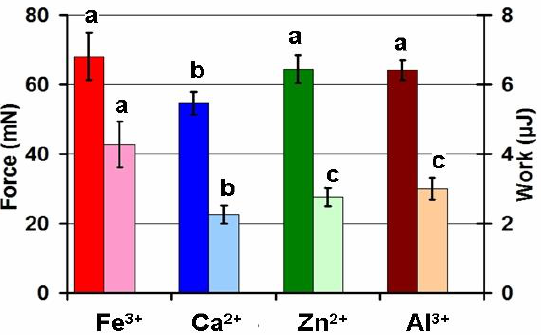
Figure 1. Comparison of the adhesion strength and work of adhesion of pectin hydrogels cross-linked by Fe 3+ , Ca 2+ , Zn 2+ , and Al 3+ ions. The data are presented as the mean ± standard deviation (SD). Different lowercase letters indicate significant differences among means for the different ions ( n = 8, p < 0.05). The red, blue, green, and brown bars correspond to the adhesion strengths of the hydrogels cross-linked by Fe 3+ , Ca 2+ , Zn 2+ , and Al 3+ ions, respectively. Pink, light blue, light green, and light brown bars correspond to the work of adhesion of the hydrogels cross-linked by Fe 3+ , Ca 2+ , Zn 2+ , and Al 3+ ions, respectively.